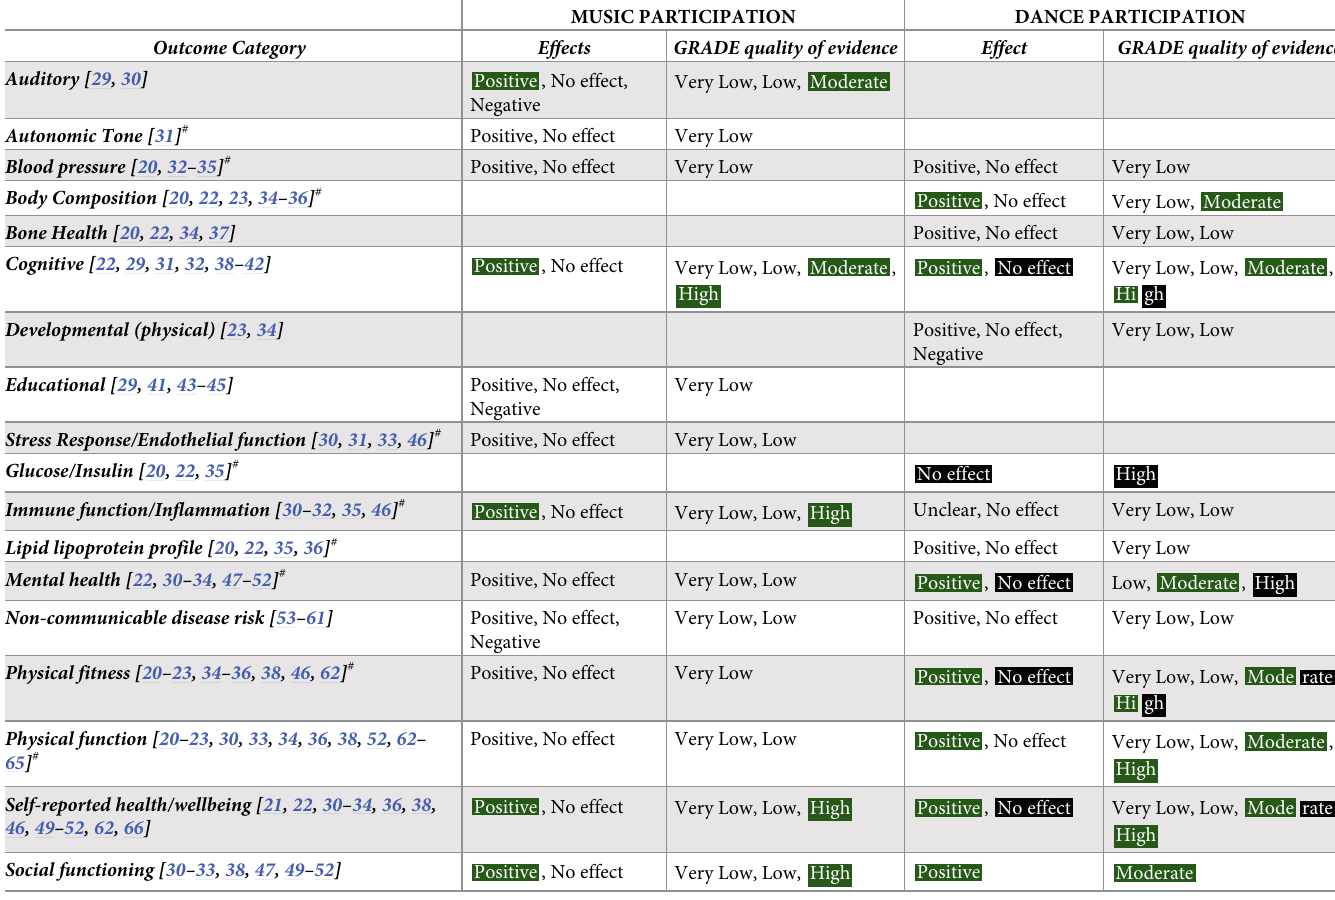
Table 1. Summary of effects of music and dance participation from included reviews and observational studies (non-communicable disease risk) on health parame- ters, grouped by